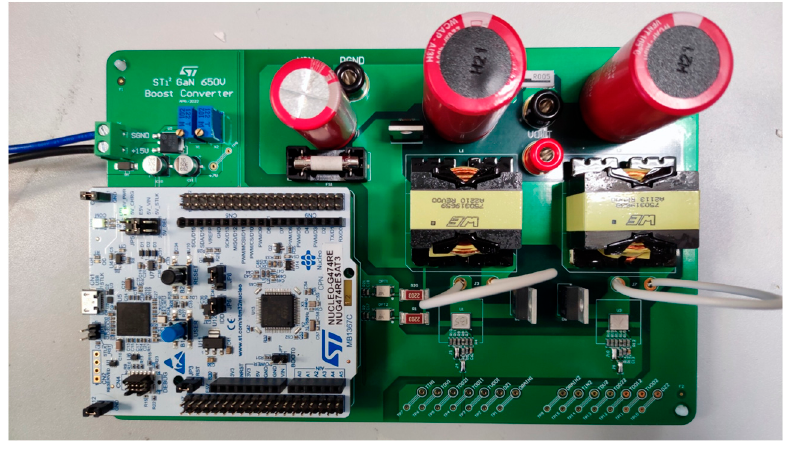
Figure 23. Interleaved boost PFC demo board.